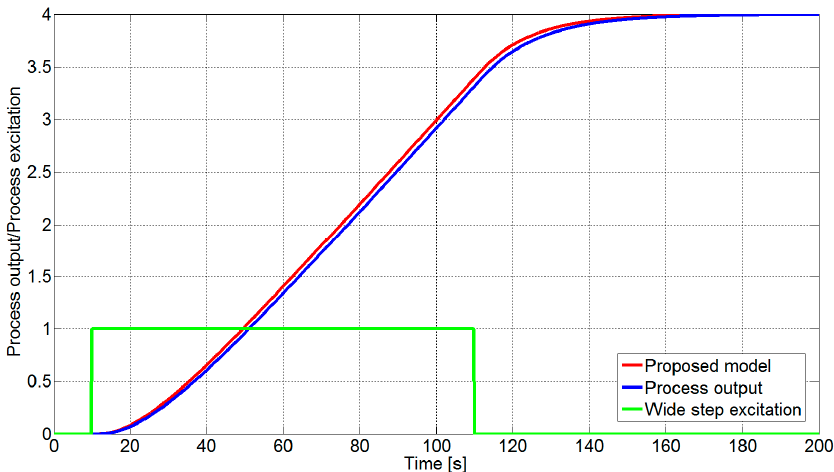
Figure 7. Wide step response of the process (blue) and proposed IFOPDT model (red), wide step excitation (green) scaled 10 times due to representation (magnitude of wide step excitation is 𝑢 = 10 ).